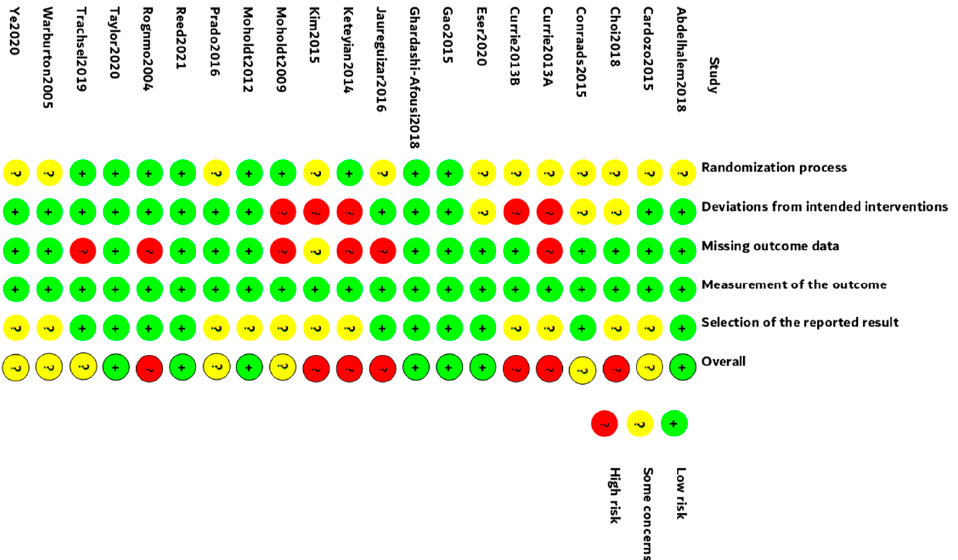
Figure 2. Quality analysis using Cochrane RoB Tool.